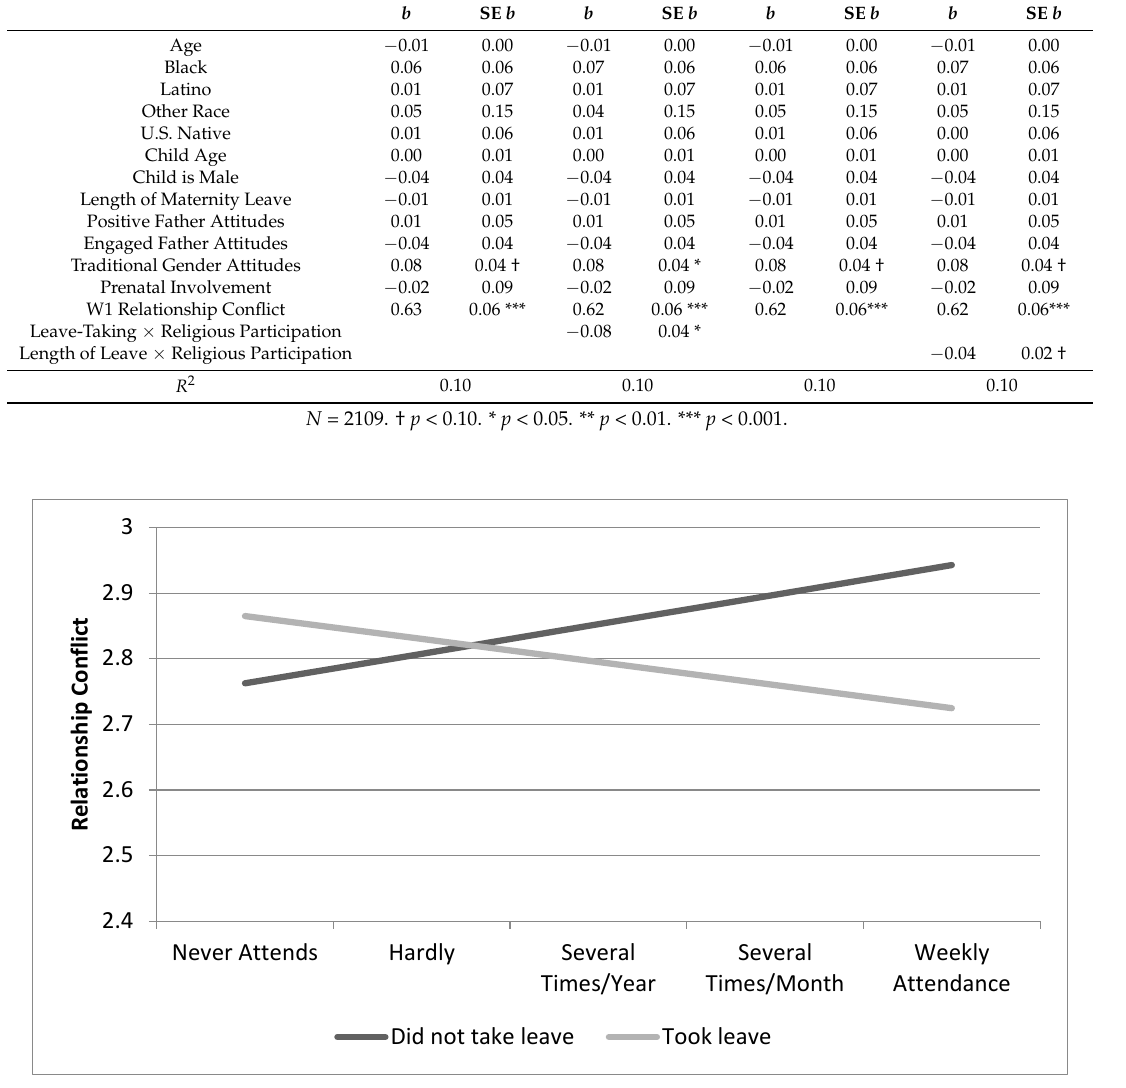
Figure 2. Predicted values of the relationships between paternity leave-taking, religious participation, and relationship conflict.